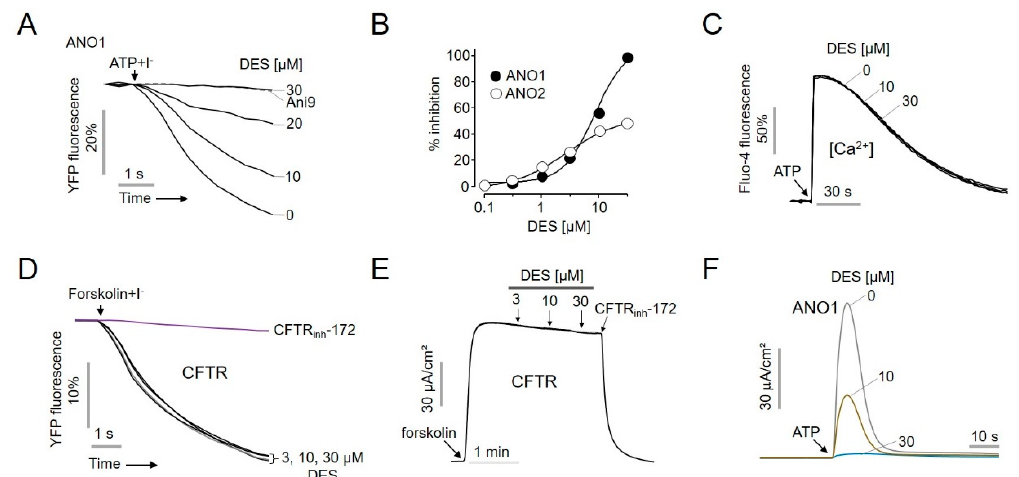
Figure 2. Characterization of the ANO1 inhibitor, diethylstilbestrol (DES). ( A ) Inhibitory effect of DES exerted on ANO1 channel activity determined using YFP fluorescence. ( B ) Summary of dose-response (mean ± S.D., n = 5). ( C ) Cytosolic Ca 2+ level was monitored using Fluo-4 NW in CHO-K1 cells. The indicated concentrations of 10 and 30 µ M DES were added for 20 min, and then treatment with 100 µ M ATP was performed. ( D , E ) Effect of DES on human CFTR activity was measured in FRT-hCFTR-YFP cells using YFP fluorescence and an Ussing chamber. The CFTR was activated in the presence of 10 µ M forskolin, whereas its activity was blocked in the presence of 10 µ M CFTR inh -172. ( F ) Apical membrane currents in FRT-hANO1 cells treated with DES for 10 min prior to ATP-induced ANO1